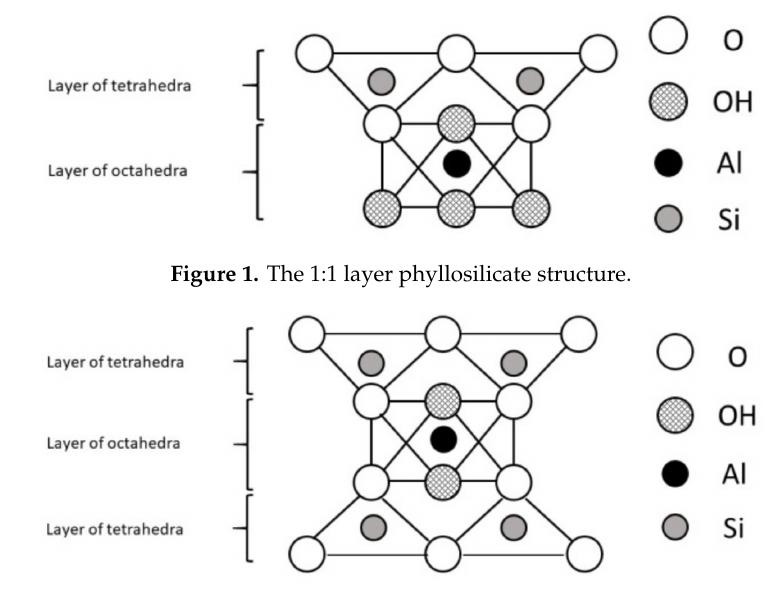
Figure 2. The 2:1 layer phyllosilicate